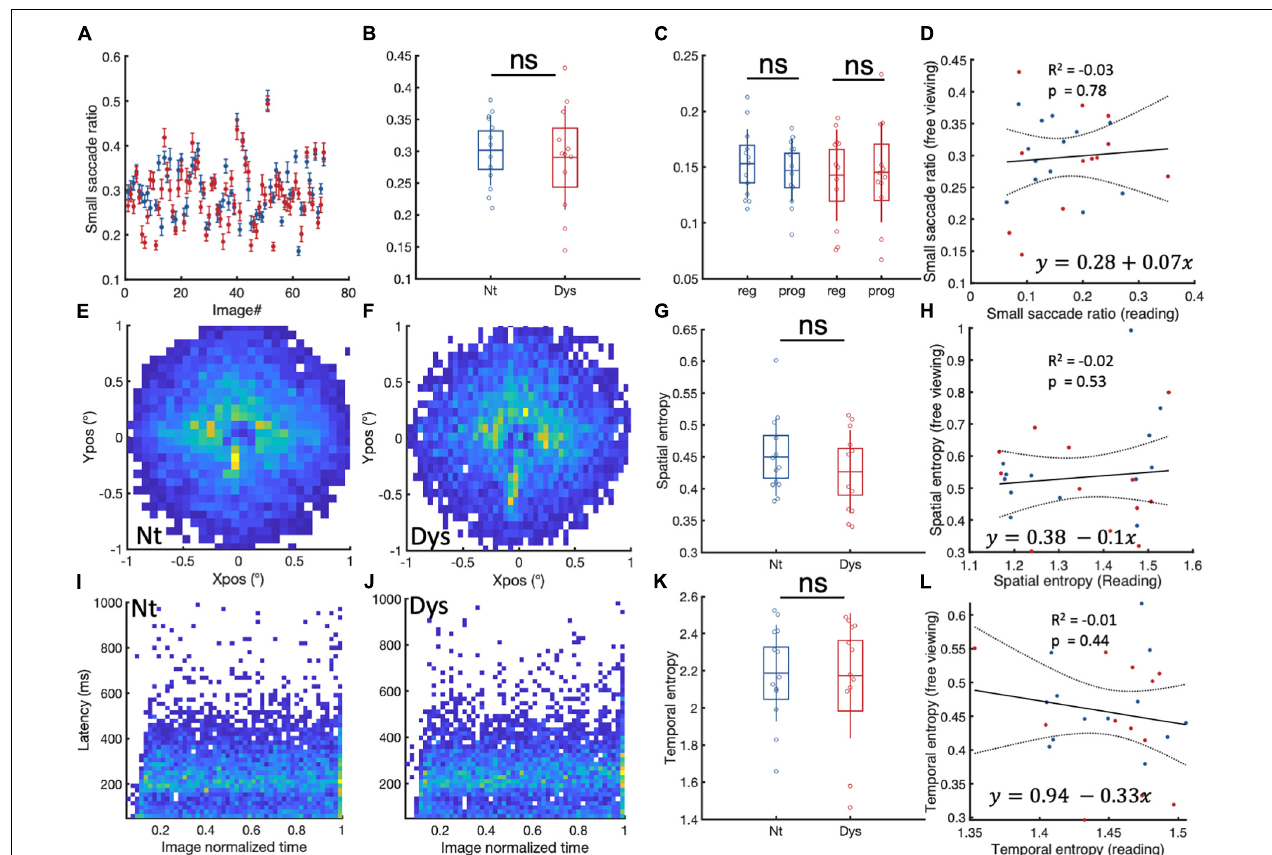
FIGURE 5 | Small saccade occurrences and spatiotemporal entropy in free viewing. (A) Paragraph specific small saccade ratios in neurotypicals (blue) and dyslexics (red). (B) Subject specific small saccade ratios for neurotypicals (blue) and dyslexics (red). (C) Comparison between regressive and progressive subject specific small saccade ratios for neurotypicals (blue) and dyslexics (red). (D) Linear regression analysis of small saccade ratio and during reading and free viewing. (E,F) Small saccade landing point distributions for neurotypicals and dyslexics, respectively. (G) Subject specific small saccade spatial entropy for neurotypicals (blue) and dyslexics (red). (H) Linear regression analysis of small saccade spatial entropy during reading and free viewing. (I,J) Small saccade temporal occurrences in neurotypicals and dyslexics, respectively. (K) Subject specific temporal entropy for neurotypicals (blue) and dyslexics (red). (L) Linear regression analysis of small saccade temporal entropy and during reading and free viewing. ns > 0.05